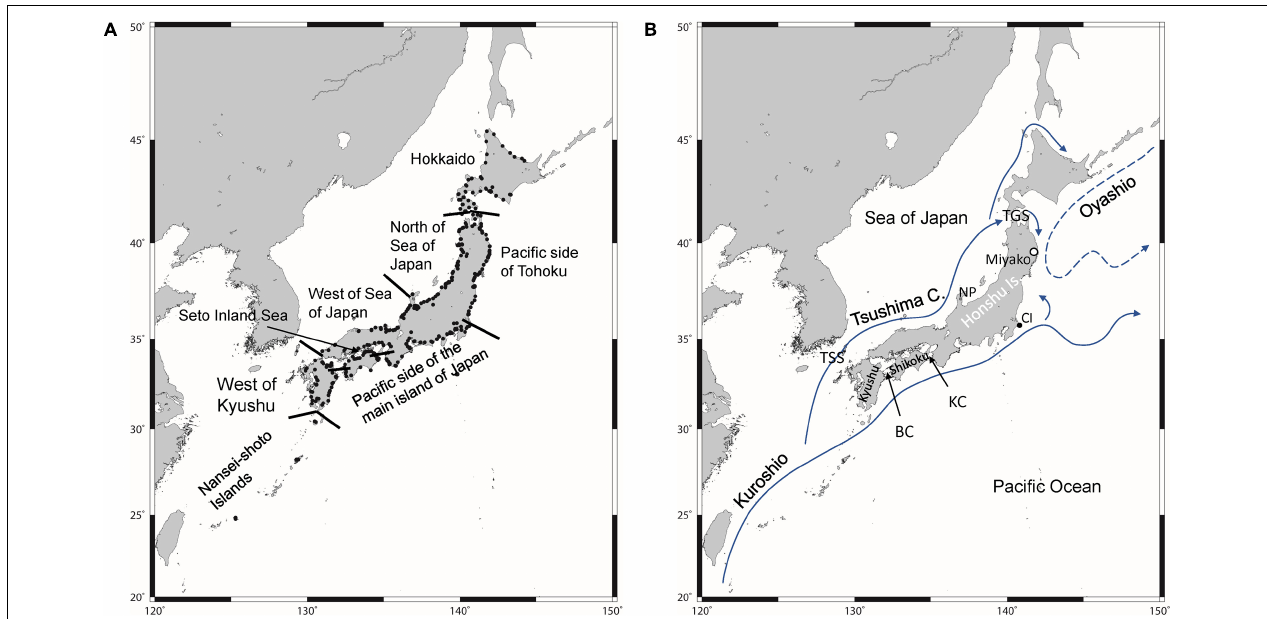
FIGURE 1 | Study area: (A) locations from where samples were collected to test for environmental DNA of Japanese eel. Black dots indicate sampling points. Solid arrows in panel (B) indicate warm currents and a dashed arrow indicates cold current. TSS, Tsushima Strait; BC, Bungo Channel; KC, Kii Channel; CI, Cape Inubozaki; TGS, Tsugaru Strait; NP, Noto